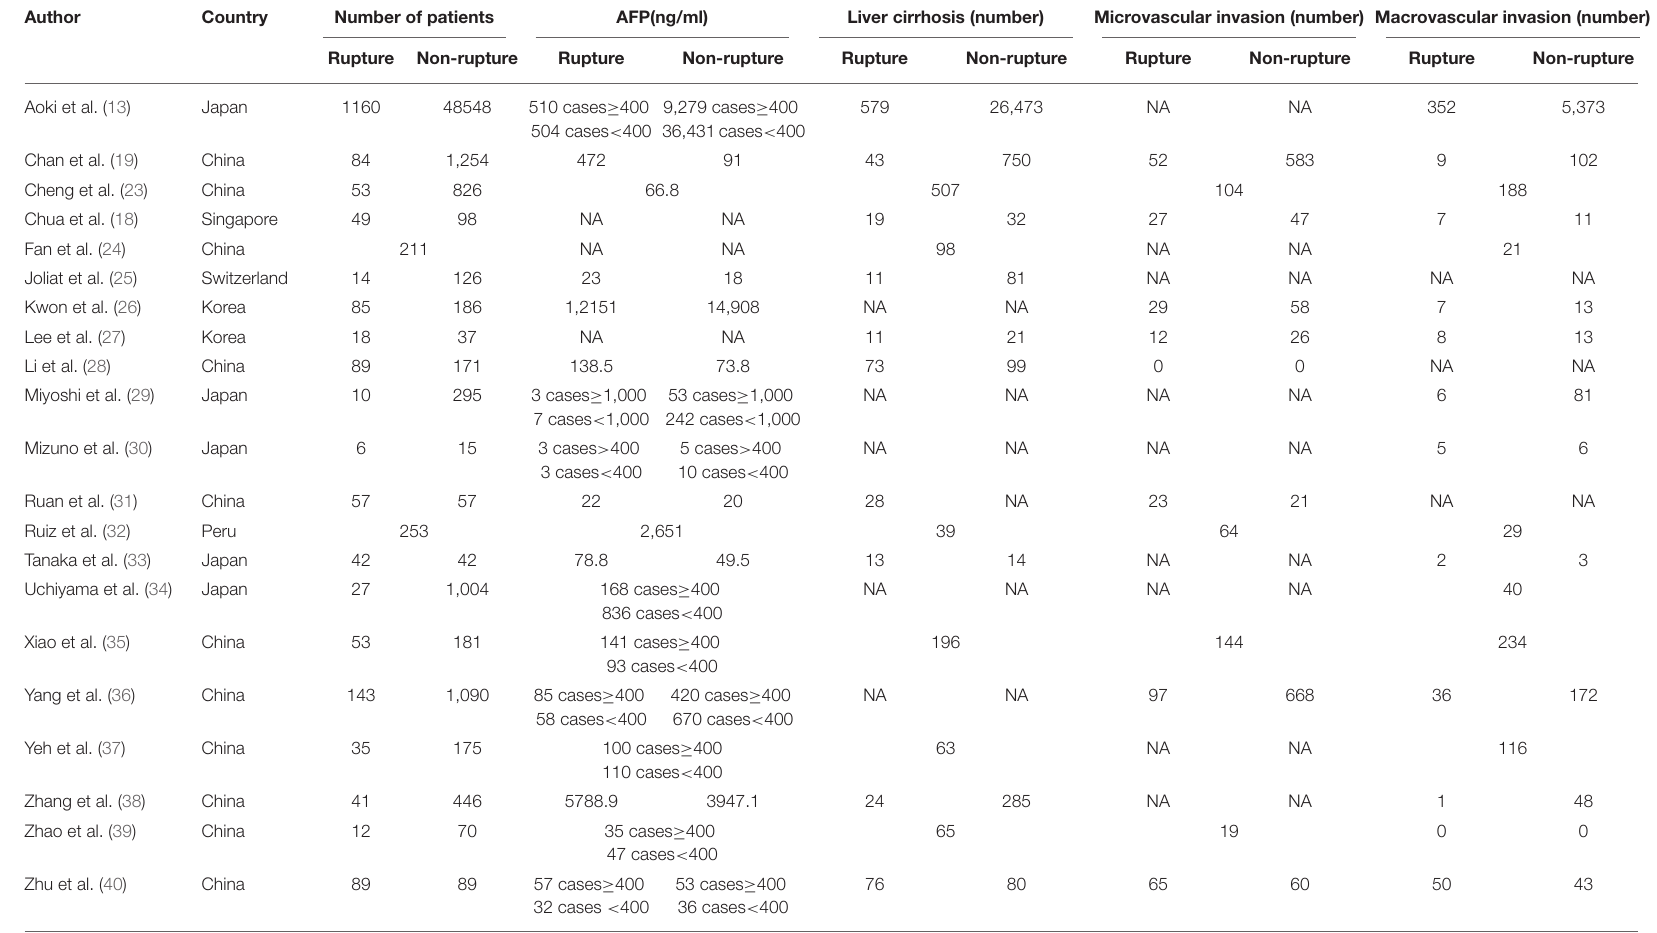
TABLE 1 | Characteristics of all the studies included in the